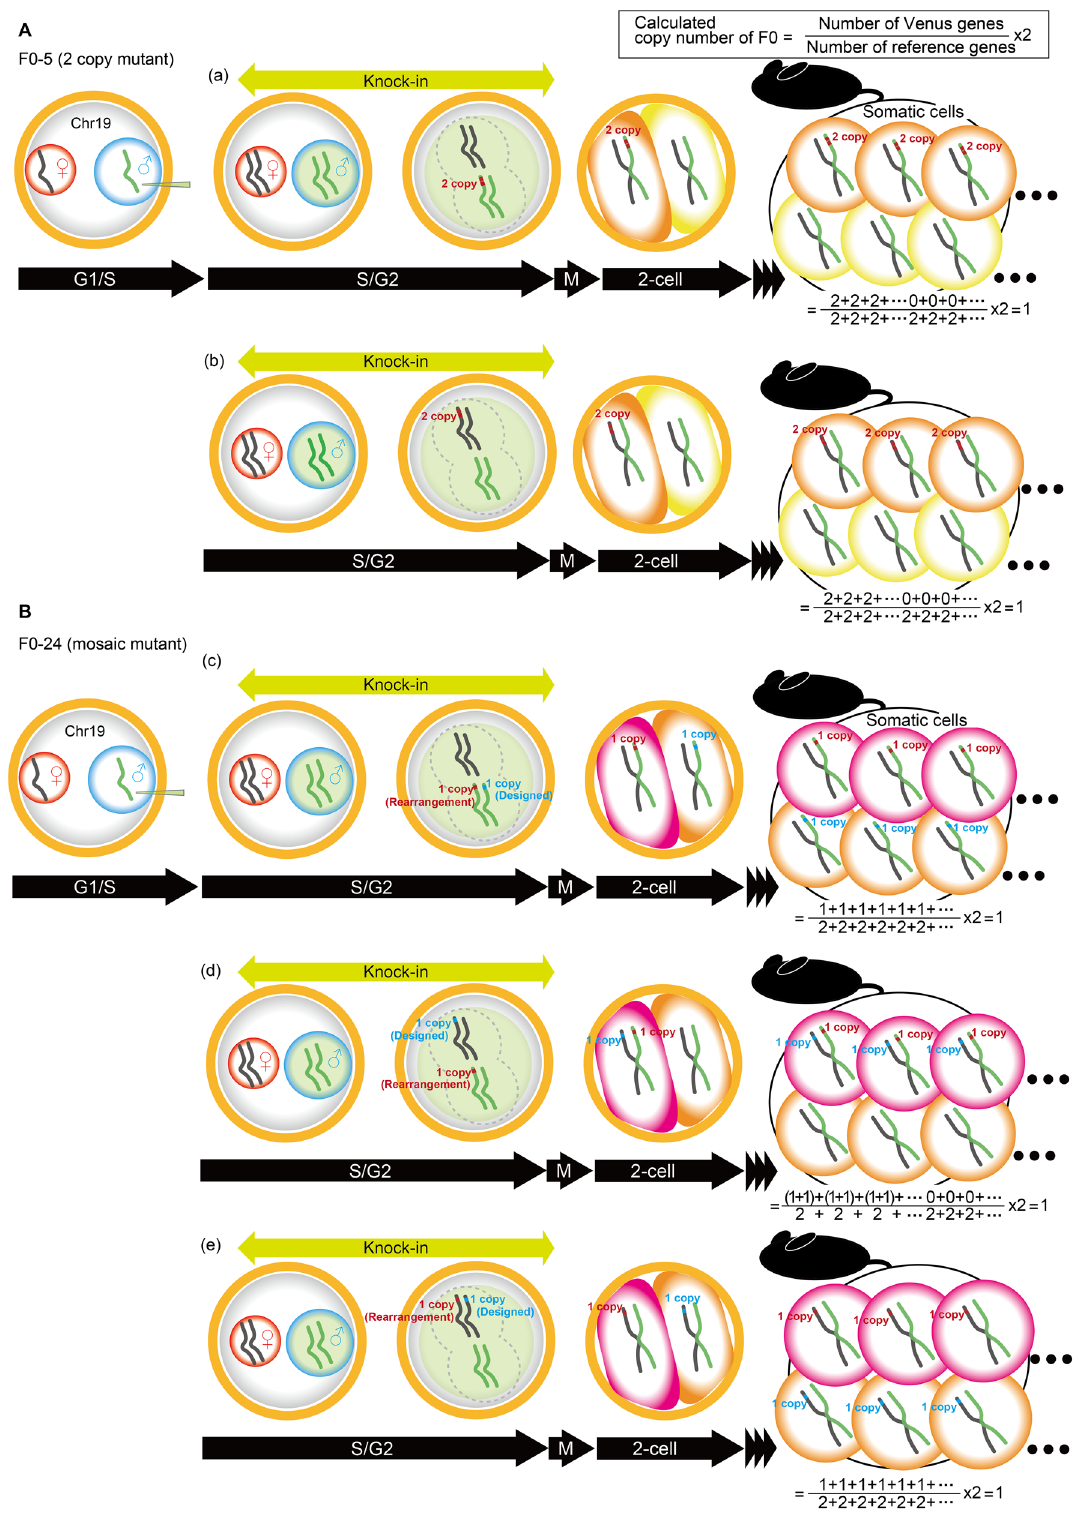
Figure 6. Schematic drawing of the estimated knock-in events that occurred at the Prlhr locus in the F0 generation. A cocktail of hCas9 mRNA, sgRNA, and lssDNA was injected into the male pronuclei of embryos. HDR-mediated knock-in events occur in the S/G2 phase of the pronuclear stage. ( A ) In F0 number 5, tandem two-copy insertions occurred on (a) one paternal or (b) one maternal chromosome. Based on droplet digital PCR using the genome extracted from the tail of F0 number 5, copy number was calculated to be a single copy mutant in either case. ( B ) In F0 number 24, single-copy insertions occurred in two different Prlhr loci, one KI allele was present as designed and the other was an allele in which rearrangement occurred: (c) two paternal chromosomes, (d) one paternal chromosome and one maternal chromosome, or (e) two maternal chromosomes. By droplet digital PCR using the genome extracted from the tail of F0 number 24, copy number was also calculated to be a single copy mutant in all